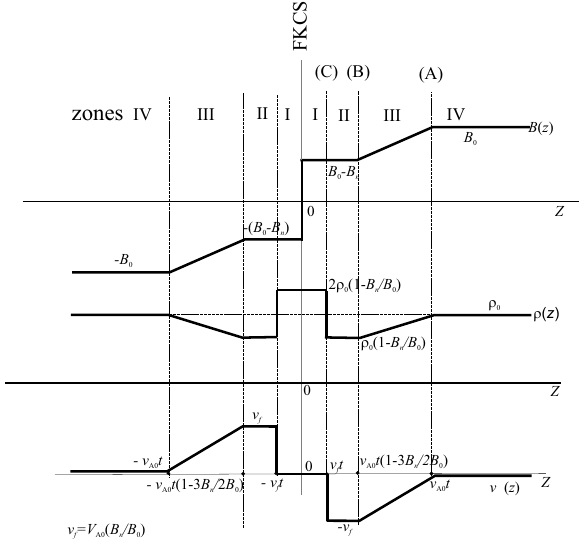
Fig. 4. Variations of density, magnetic field, and velocity in the plasma flows on both sides of the